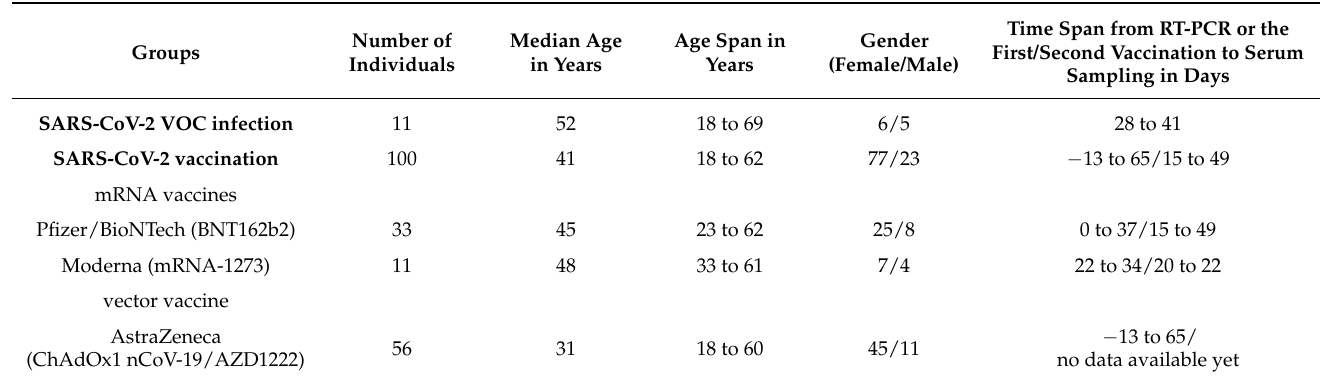
Table 1. Composition of the study groups.